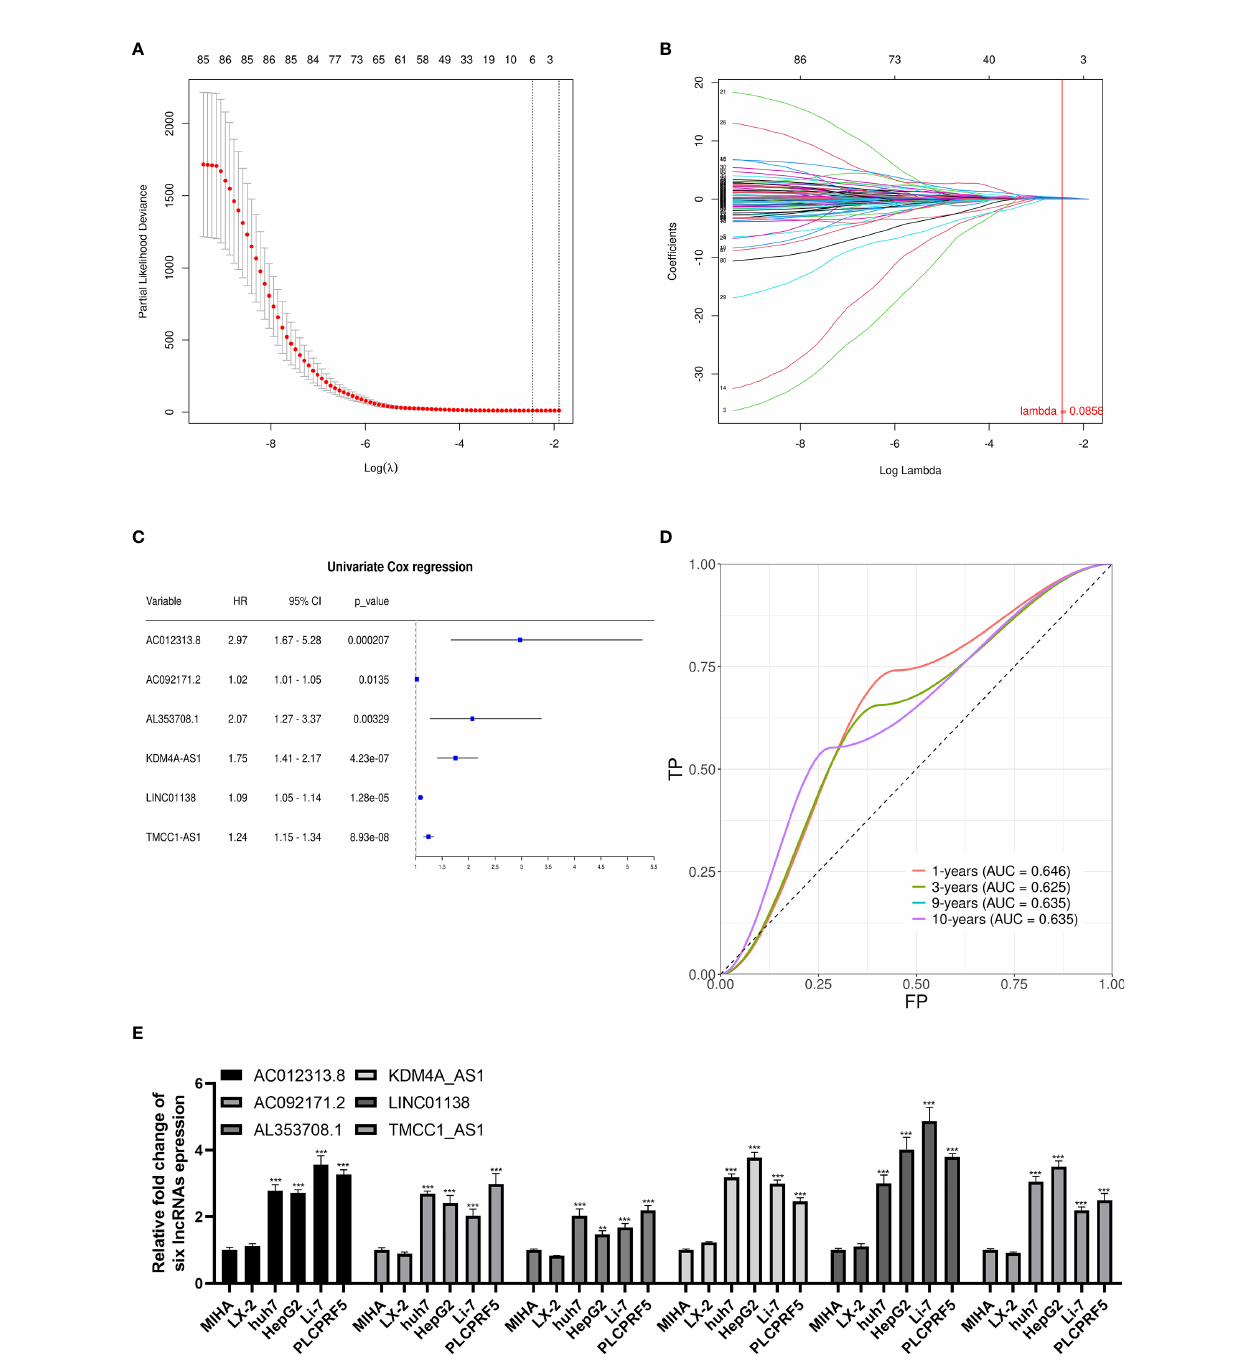
FIGURE 3 | Lasso regression signature construction and validation. (A) Determination of the penalty value based on the lowest point of the lasso regression curve. (B) The lncRNAs that make up the signature were included according to whether the penalty values intersected each curve, and the regression coef fi cients were calculated. (C) Univariate cox regression analysis of the lncRNAs in the signature revealed that each lncRNA in the signature was associated with prognosis. (D) The calculation of the prediction accuracy of the signature at different time nodes using the ROC curve. (E) AC012313.8, AC092171.2, AL353708.1, KDM4A-AS1, LINC01138, and TMCC1-AS1 are signi fi cantly expressed higher in HCC cells than normal liver cells. **p < 0.01, ***p < 0.001.